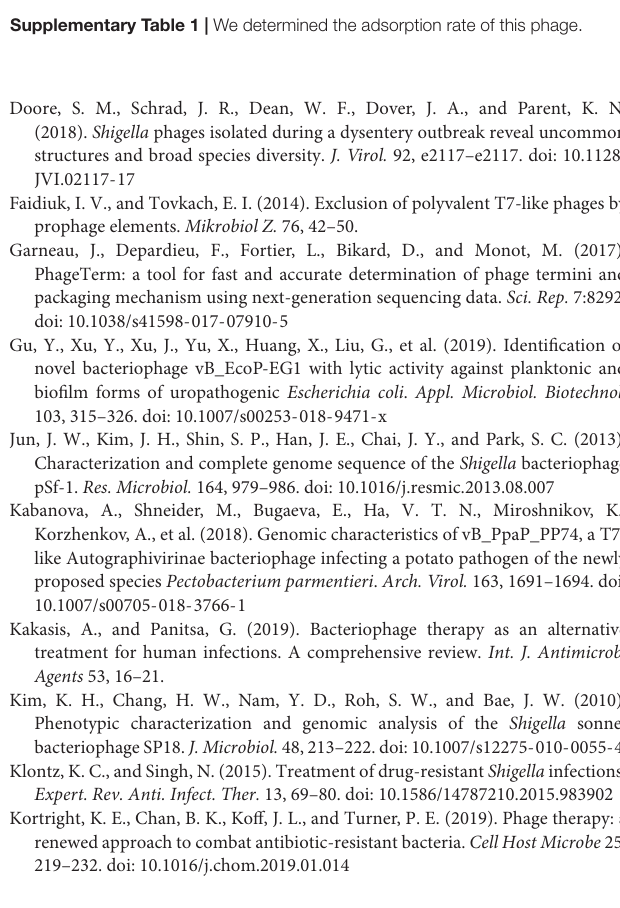
Supplementary Figure 2 | Phylogenetic tree based on the major capsid proteins’ sequence of vB_ShiP-A7 and its related phages. Supplementary Figure 3 | Phylogenetic tree based on the tail fiber proteins’ sequence of vB_ShiP-A7 and its related phages. Supplementary Table 1 | We determined the adsorption rate of this